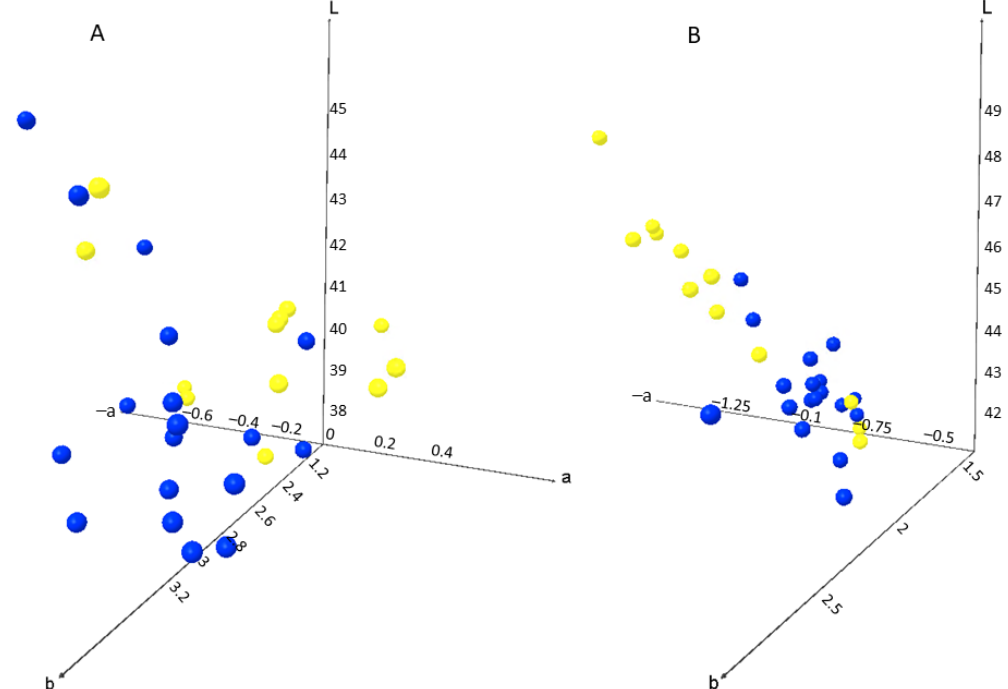
Figure 2. L*a*b* colorimetry for musts ( A ) and wines ( B ) from two Dalmatian subregions (blue dots represent data from Central and Southern Dalmatia and yellow dots represent data from Northern Dalmatia).